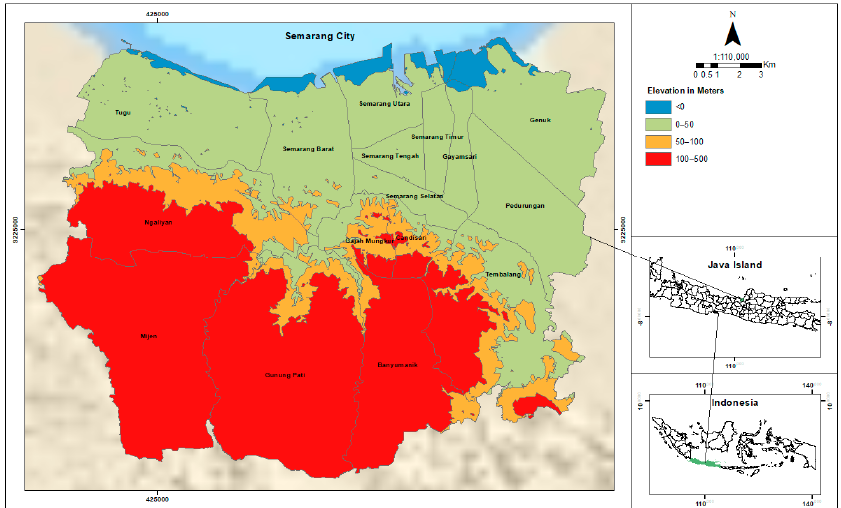
Figure 1. Research area, Semarang City: Variety of elevations between the northern and south- ern